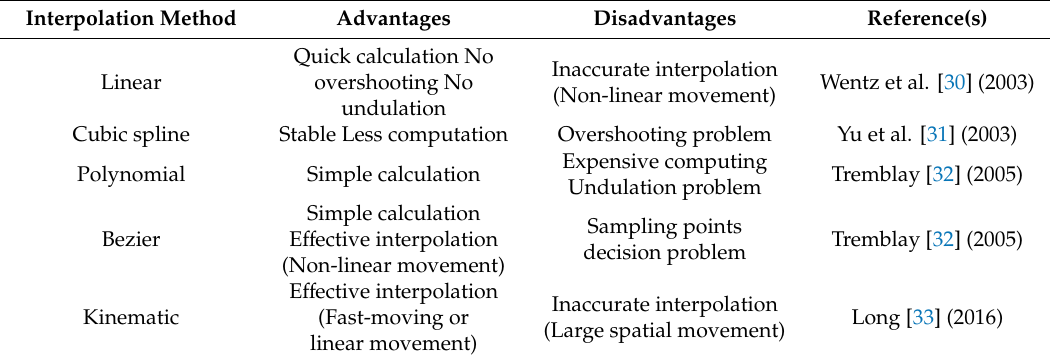
Table 1. Comparison of major interpolation